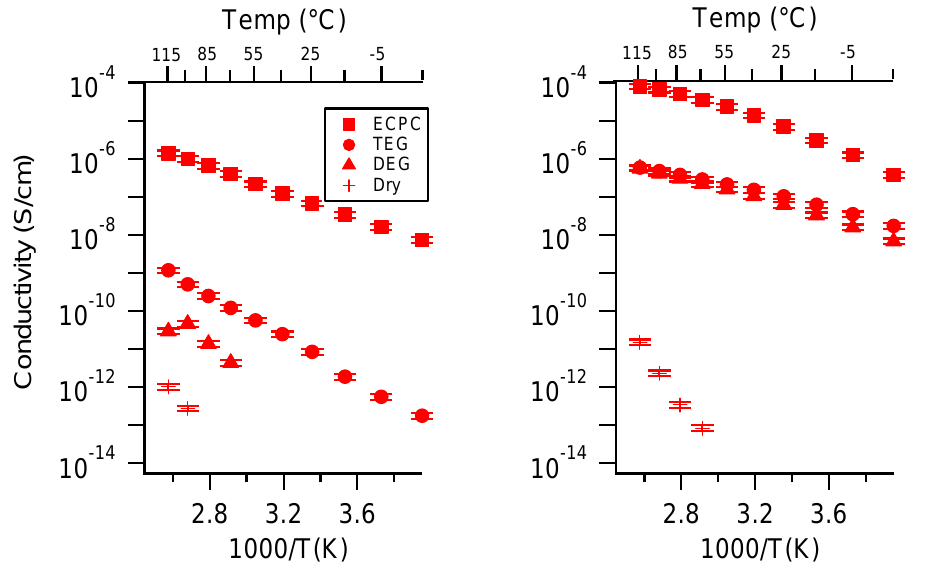
Figure A31. Conductivity as a function of solvent for PEGDMA1000_high_SSCa (left) and PTHFDA1000_high_STFSICa (right) SIPEs. Temperatures ranged from − 20 °C to 115 °C. Note that there may be a non-negligible fraction of electronic conductivity in conditions where conductivity of less than 10 − 9 S / cm is